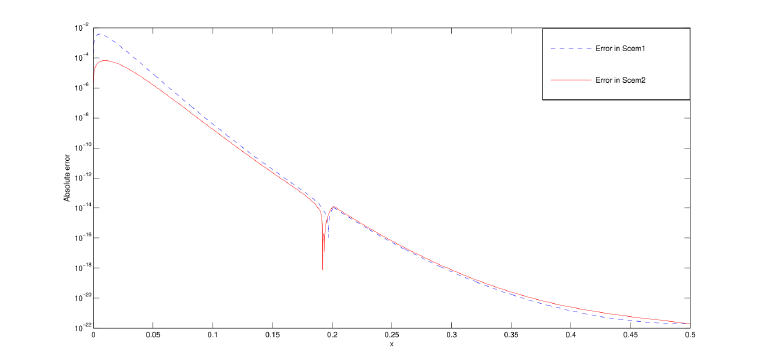
Figure 2. Absolute errors in SCEM approximations y sceml homogeneous problem (4.1)–(4.2); ε = 0 . 01. The second SCEM approximations is slightly